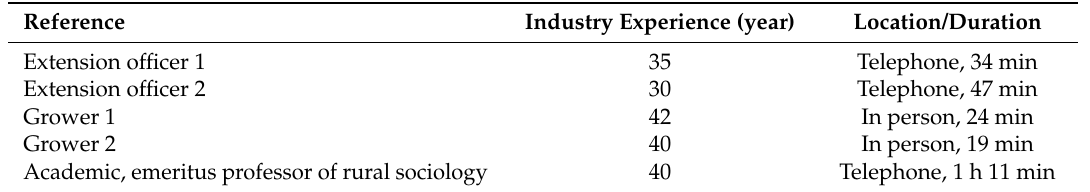
Table 2. Semi-structured interviews—list of industry specialists